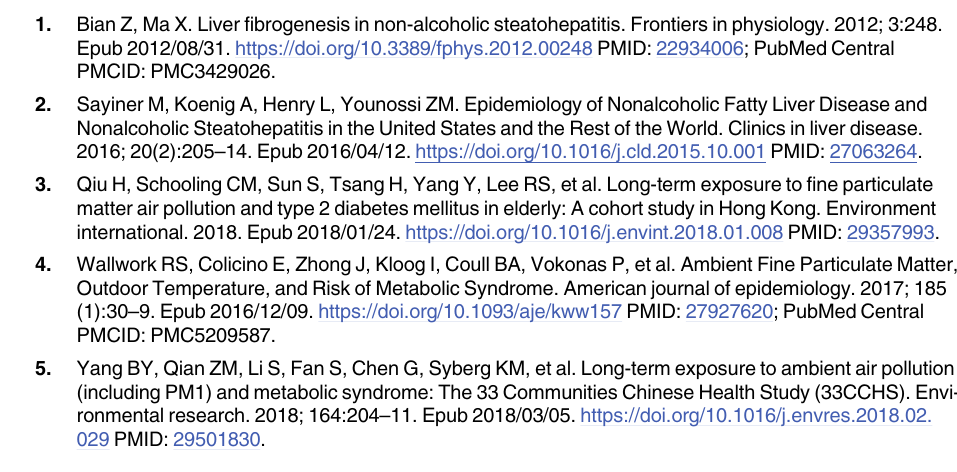
S8 Fig. The protein levels of LaminB1 in liver of four groups. (JPG) S9 Fig. The protein levels of LC3B in liver of four groups. (JPG) S10 Fig. The protein levels of Beta-Actin in liver of four groups.